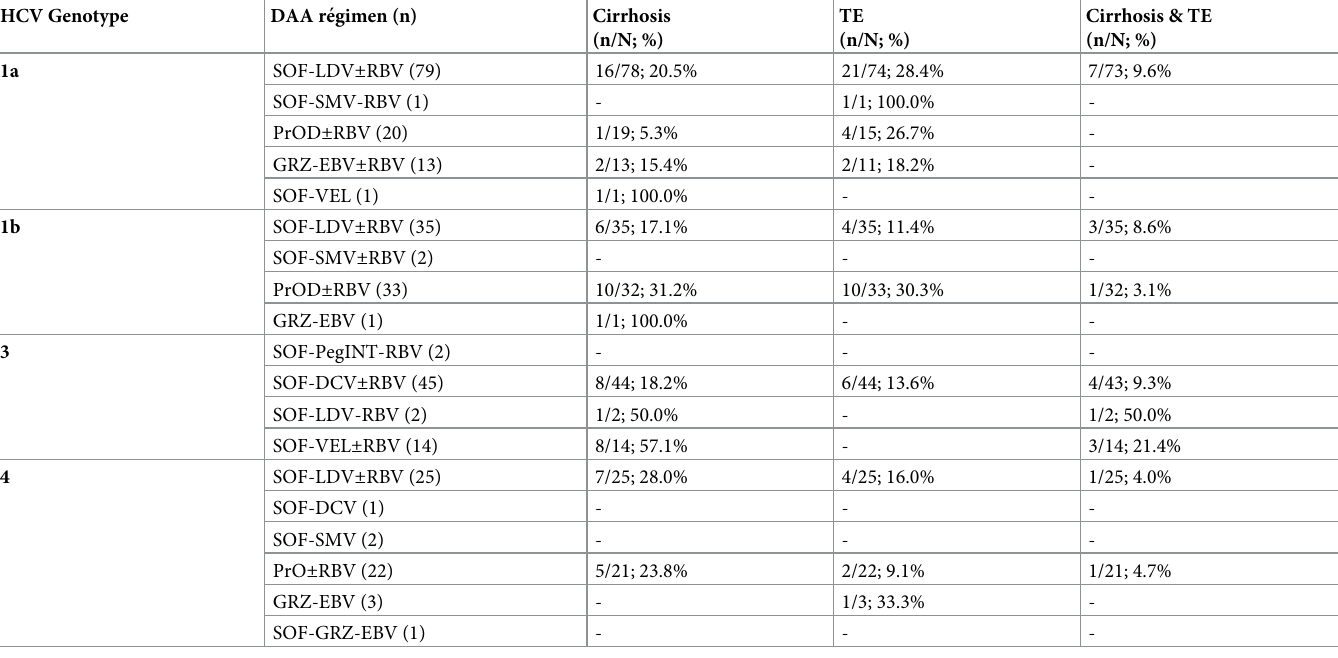
Table 3. DAA regimens used according to HCV genotype, cirrhosis and previous treatment experience (TE). HCV Genotype